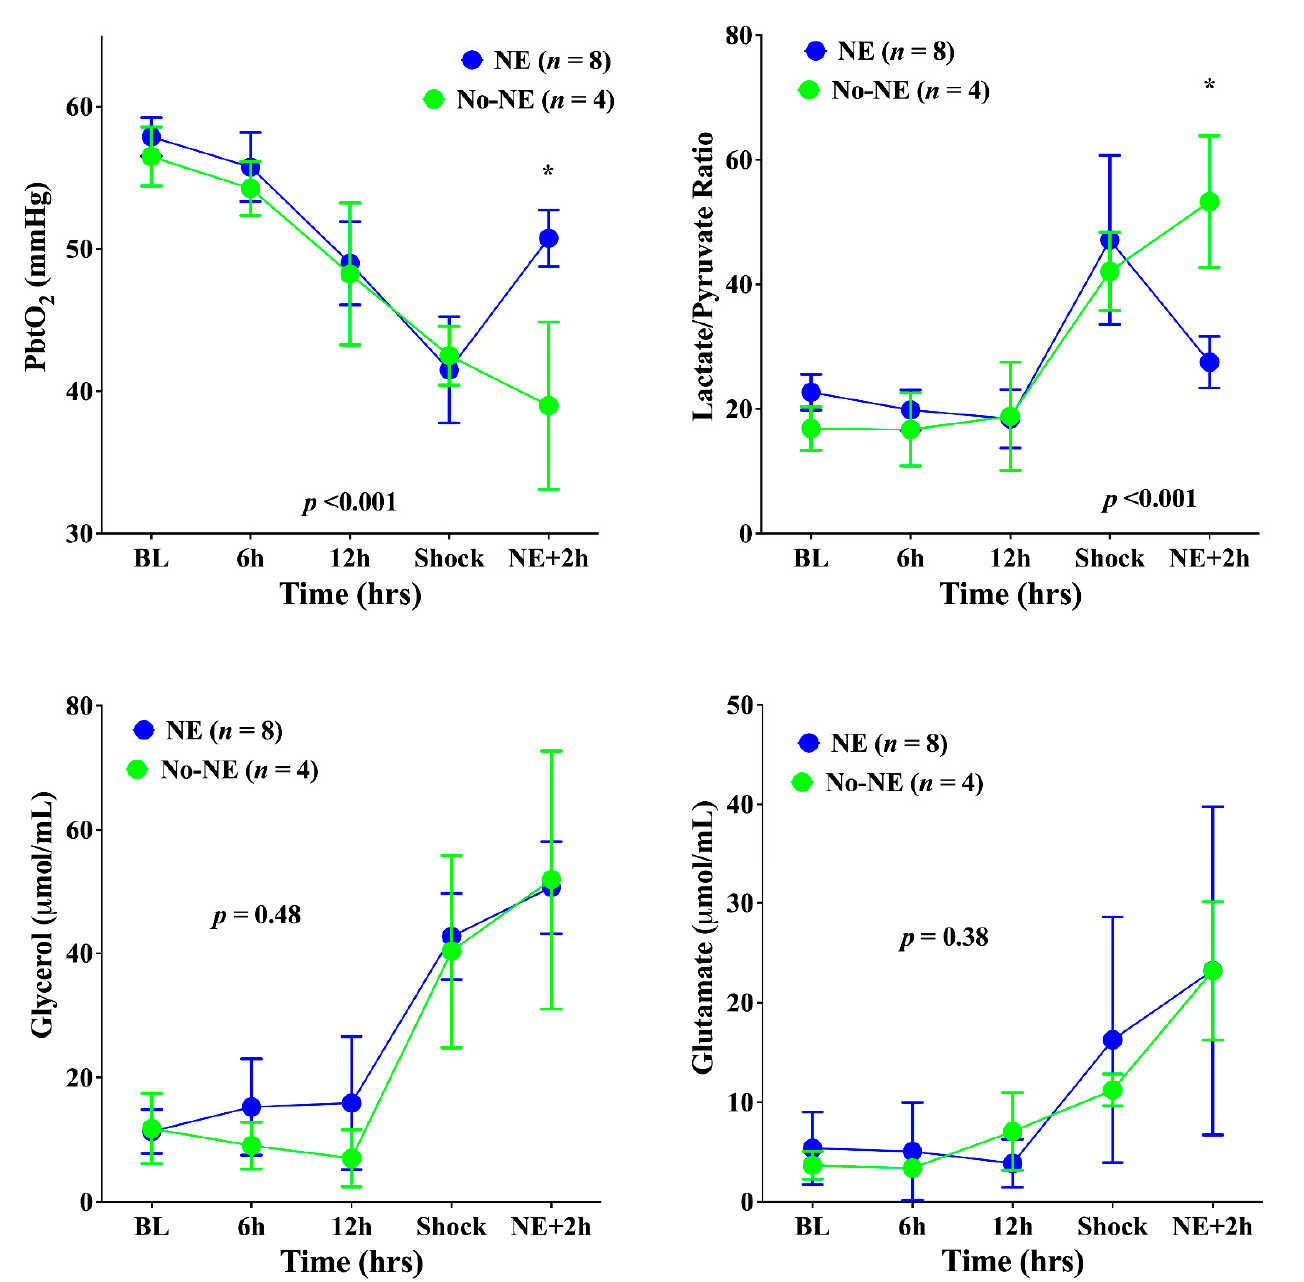
Figure 3. Time-course of the brain oxygen pressure (PbtO 2 ), the cerebral lactate/pyruvate ratio, cerebral glycerol, and cerebral glutamate in the two groups. NE, norepinephrine. Data are presented as mean ± SEM. * p < 0.05 from Sidak post hoc analysis.